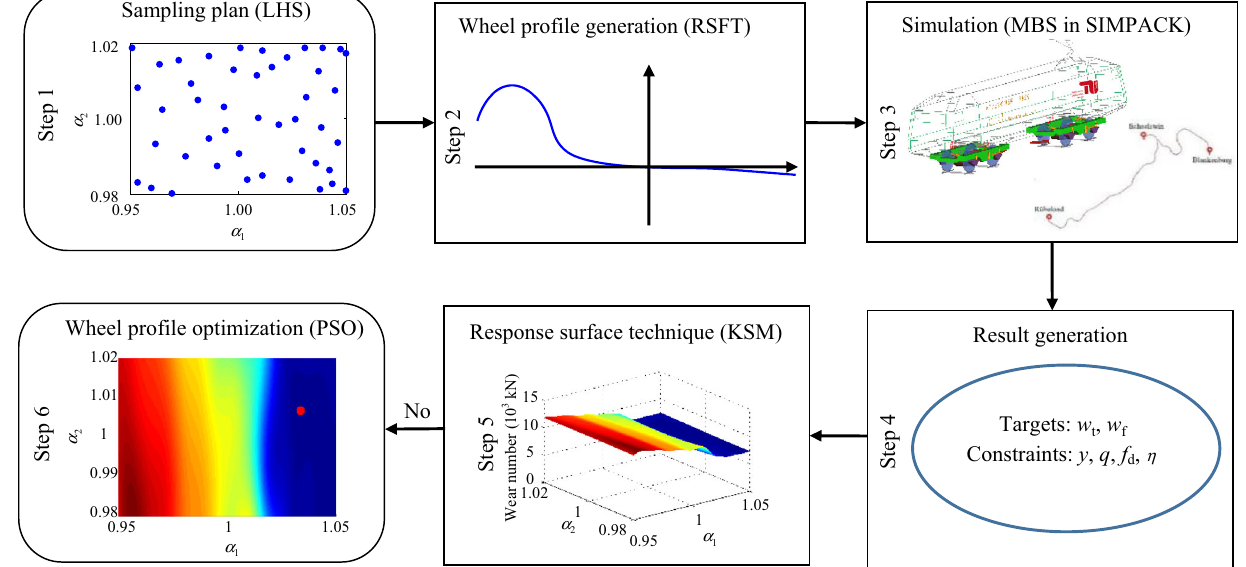
Fig. 11 Steps of the RSFT–KSM–PSO method for wheel wear